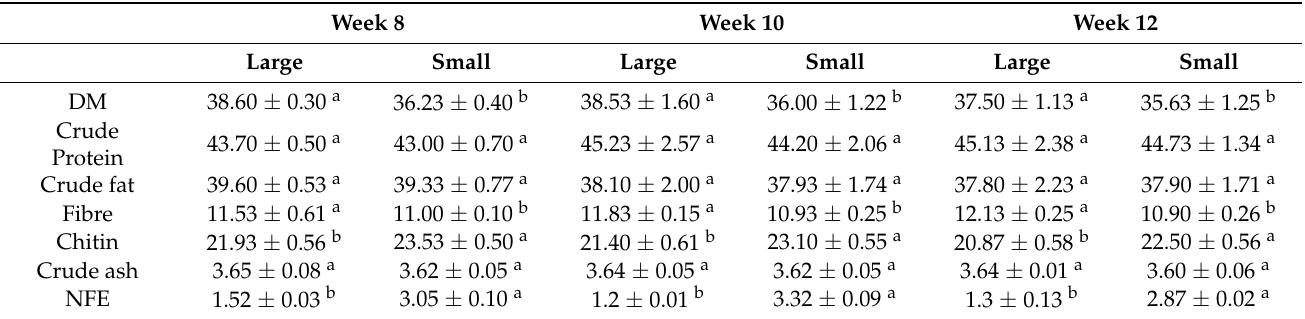
Table 7. Average nutrient composition of yellow mealworm at different ages and sizes (%).